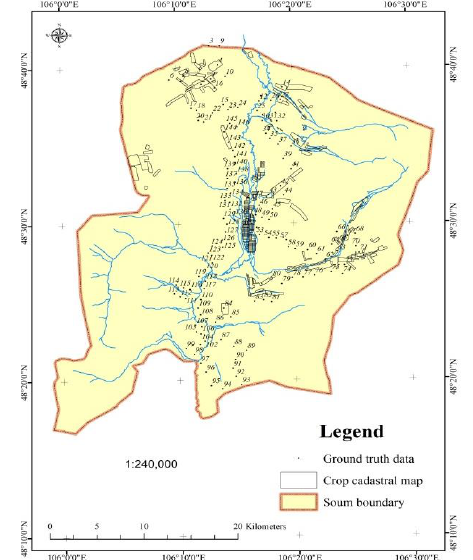
Figure 2. Cropland cadastral and field data of the Bornuur